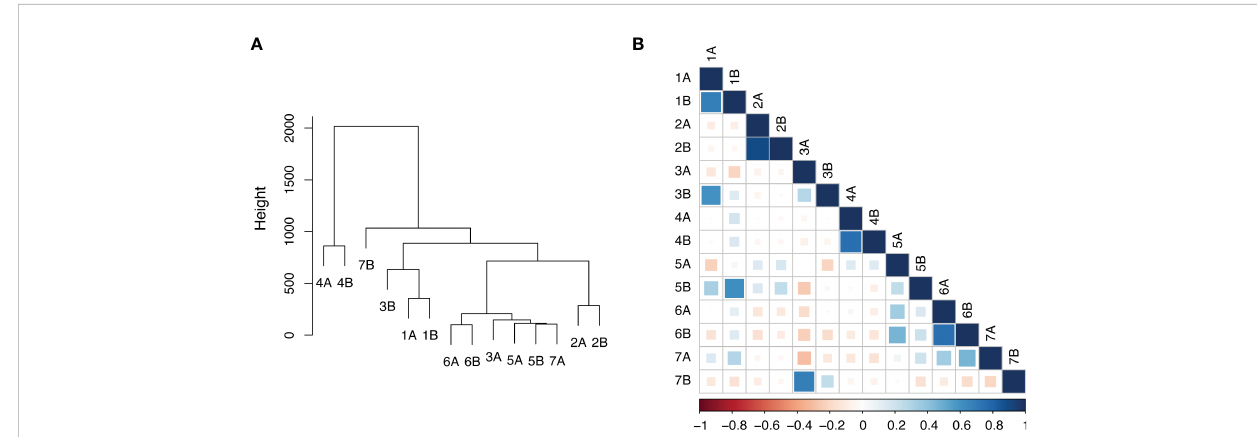
FIGURE 9 Cluster and correlation analysis of apple GA2ox genes. (A) The dendrogram depicts the relationship among the 14 MdGA2ox genes based on their expression. The y axis represents Euclidean distance ( ‘ Height ’ ). (B) Expression correlation. The heat map represents the correlation values between MdGA2ox genes (dark blue, strongly positively correlated; dark red, strongly negatively correlated).